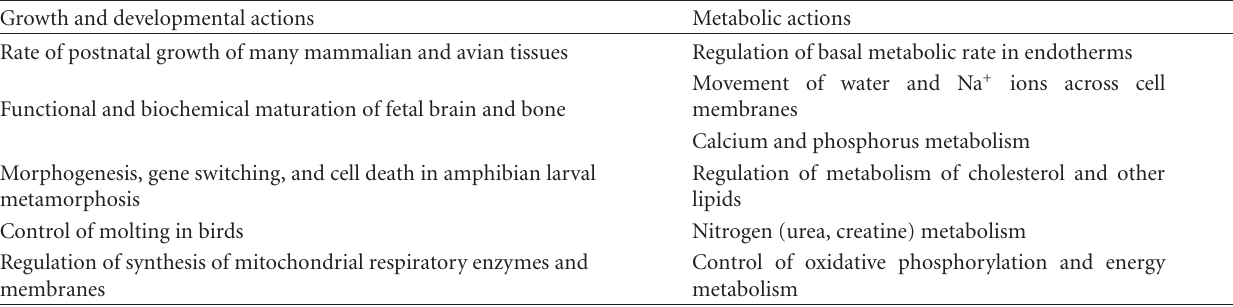
Table 1: Multiplicity of physiological and biochemical actions of thyroid